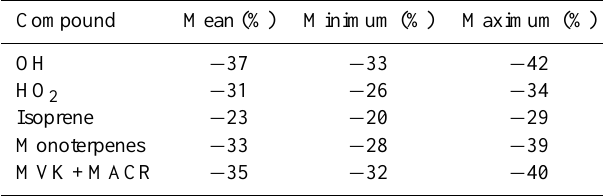
Table 1. Mean percentage underestimation of fluxes for different compounds. In addition the minimum and maximum values for the measuring period 09:00–15:00CET (25 July 2003) are given. The calculation (Eq. 8) is for τ F =2s.